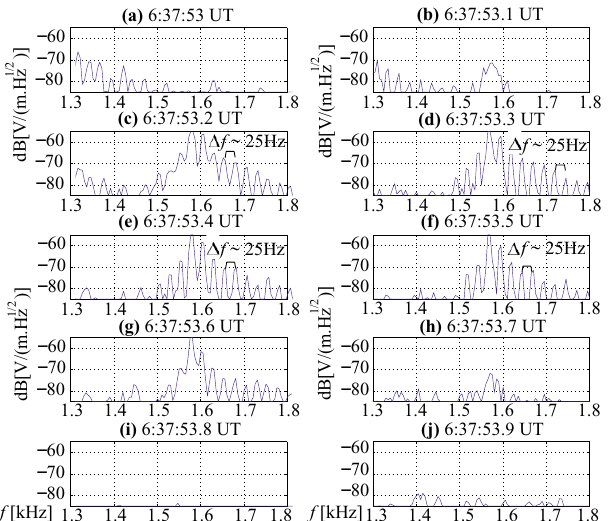
Fig. 11. Detailed power spectrum of the 0.5-s pulse detected on spacecraft SC3, at 06:37:53 UT. Each of the ten panels, from (a) to (j) correspond to a different spectrum obtained at time intervals of 0.1s. Highlighted in panels (c) , (d) , (e) and (f) is the separation be- tween sidebands, of ∼ 25Hz. The magnitude scale refers to electric field intensity.